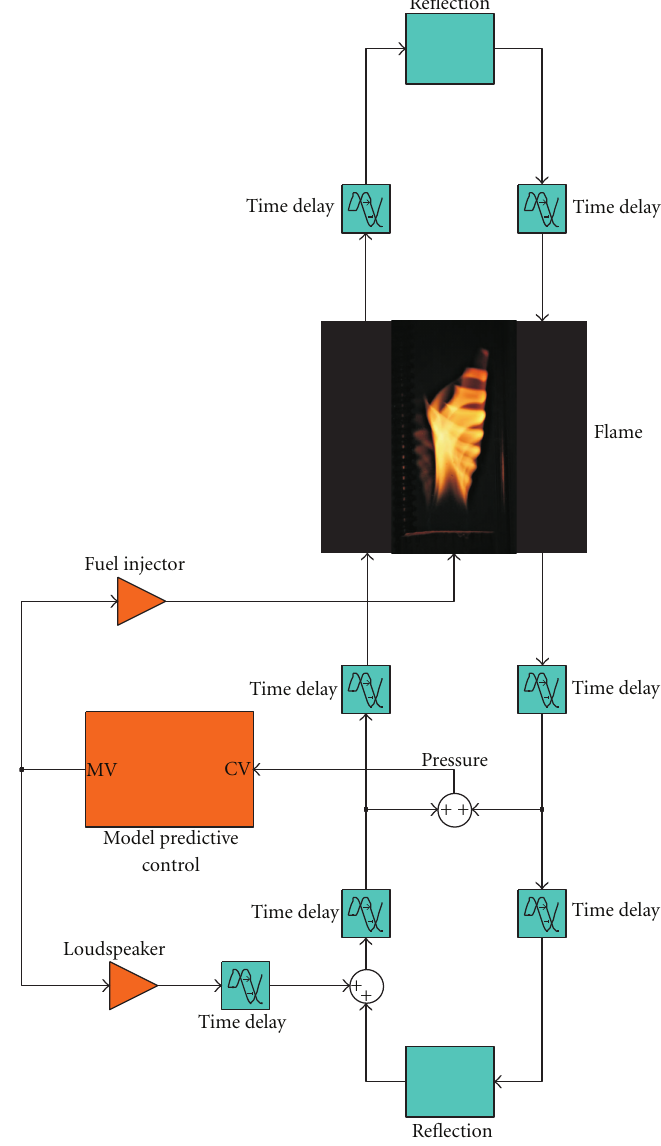
Figure 3: Signal-oriented model of the Rijke tube in